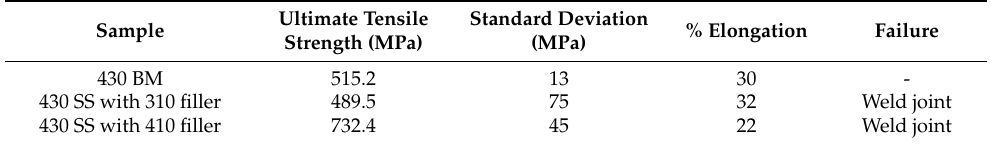
Table 5. Mechanical properties of various samples.